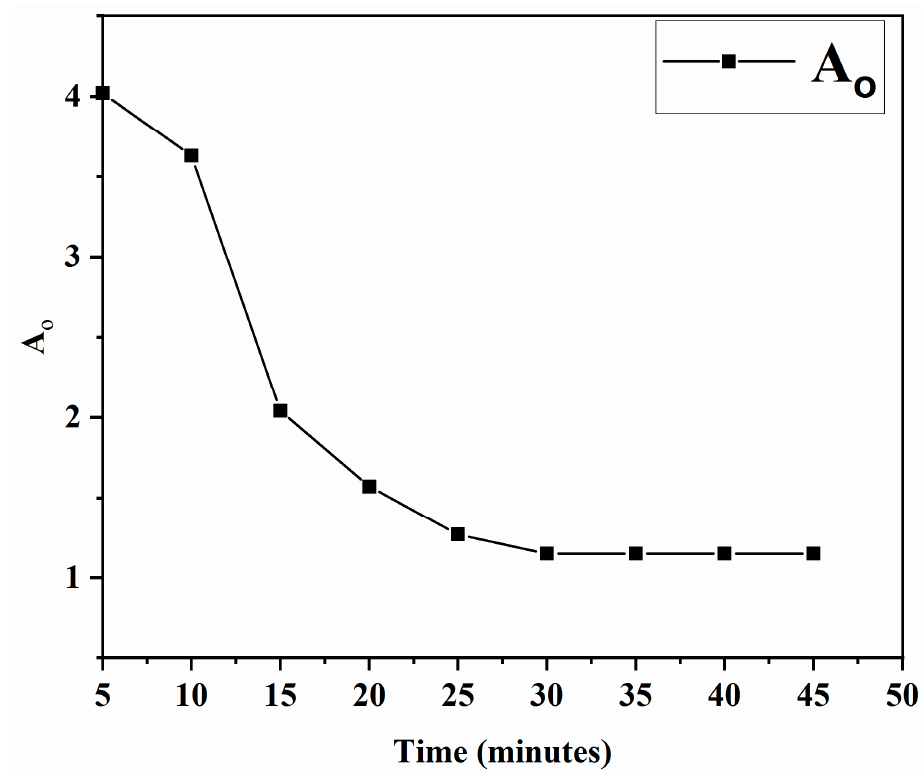
Figure 12. Adsorption of methylene blue (MB) on Co 0.5 Al 0.3 Fe 1.7 O 0.4.